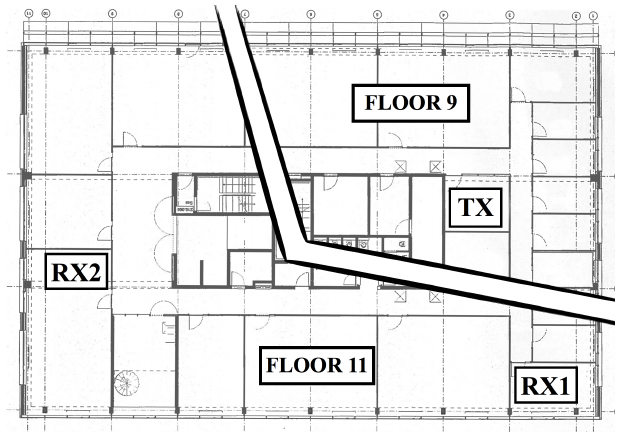
Figure 8. Indoor node